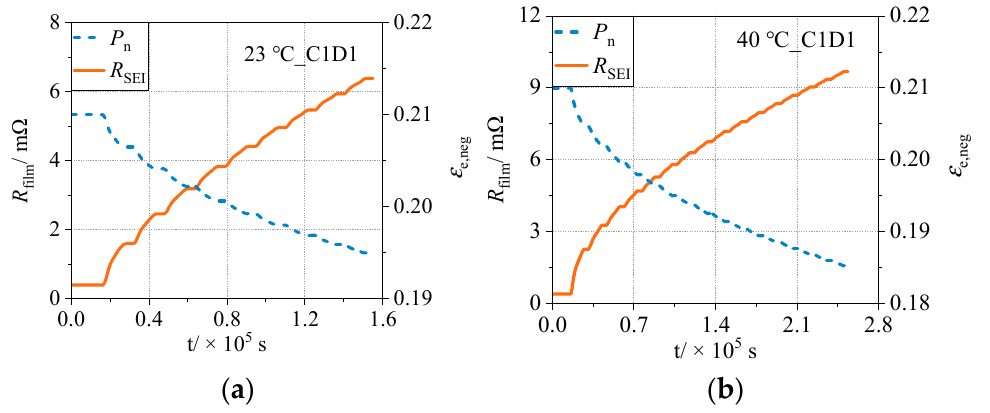
Figure 9. Variation in SEI resistance and negative porosity during cyclic aging at ( a ) 23 °C and ( b ) 40 °C.